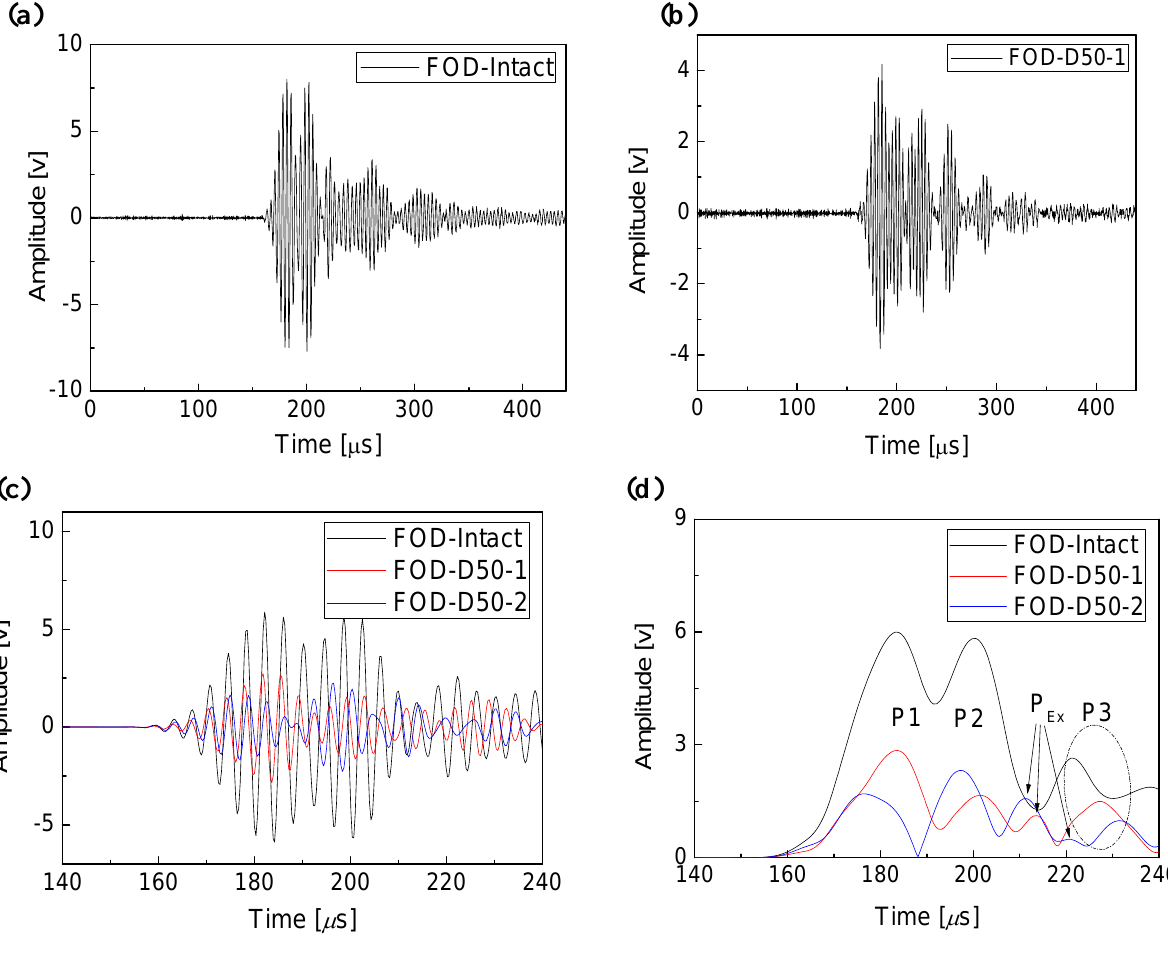
Figure 8. FOD-based results. Guided wave signals of the intact (a) and the single- delaminated (b) CFRP laminates. Waveforms (c) of the filtered guided wave signals of the intact and the damaged CFRP laminates and their Envelopes (d).